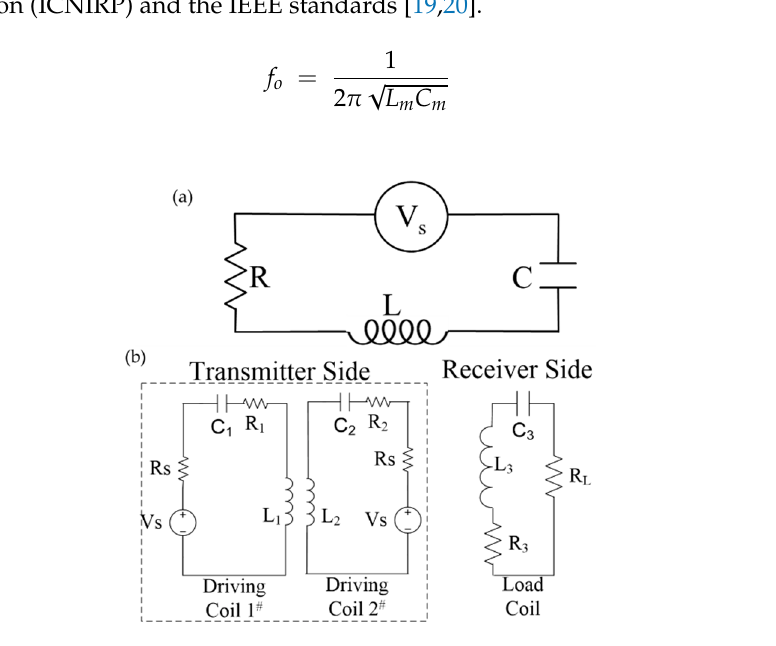
Figure 5. ( a ) Basic coil lumped circuit; ( b ) circuit model of the 3-coil R-WPT system. Table 2. Experimental verification of coils’ Q factor and inductance: (M) denotes measurement; and (S) denotes simulation result. Coil